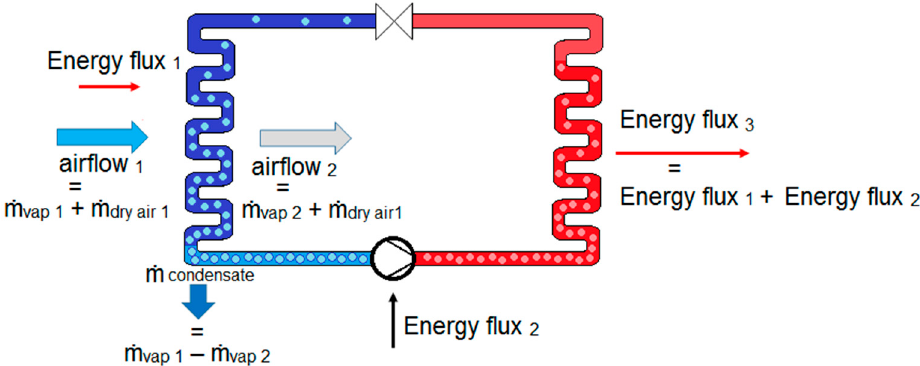
Figure 1. A representative reverse thermodynamic cycle. The mass and energy fluxes, related to the thermodynamic process are summarised in Figure 2.